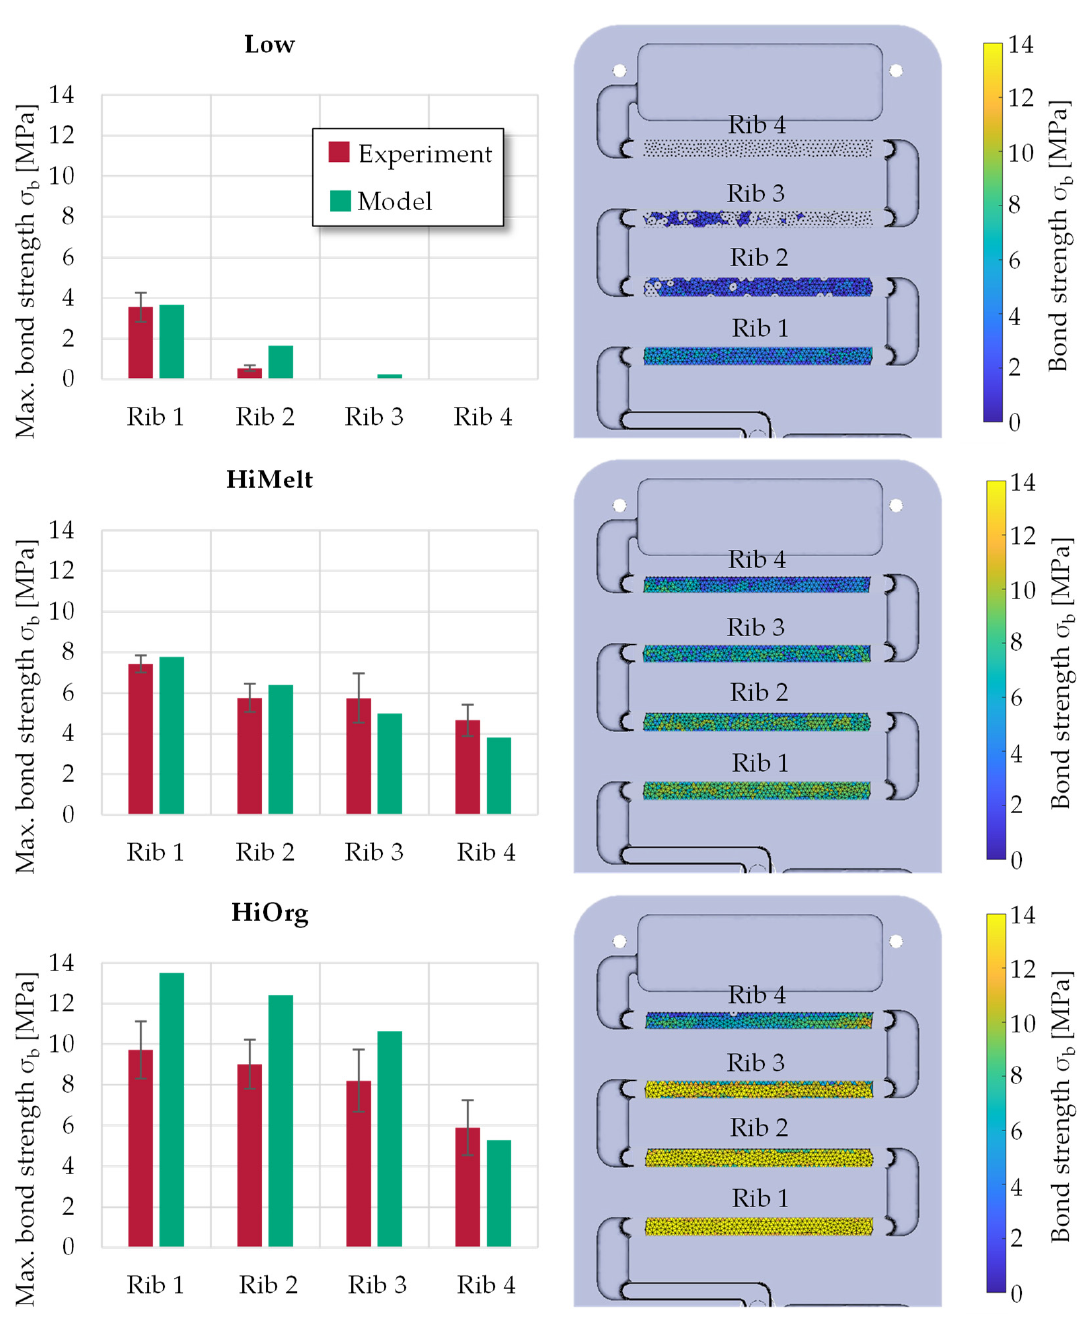
Figure 16. Comparison of the experimental and numerical bond strength for the individual ribs depending on low process temperatures (“Low”), a high melt temperature “HiMelt”, and a high organo sheet temperature “HiOrg” (cf. Table 1) and the corresponding final process states.